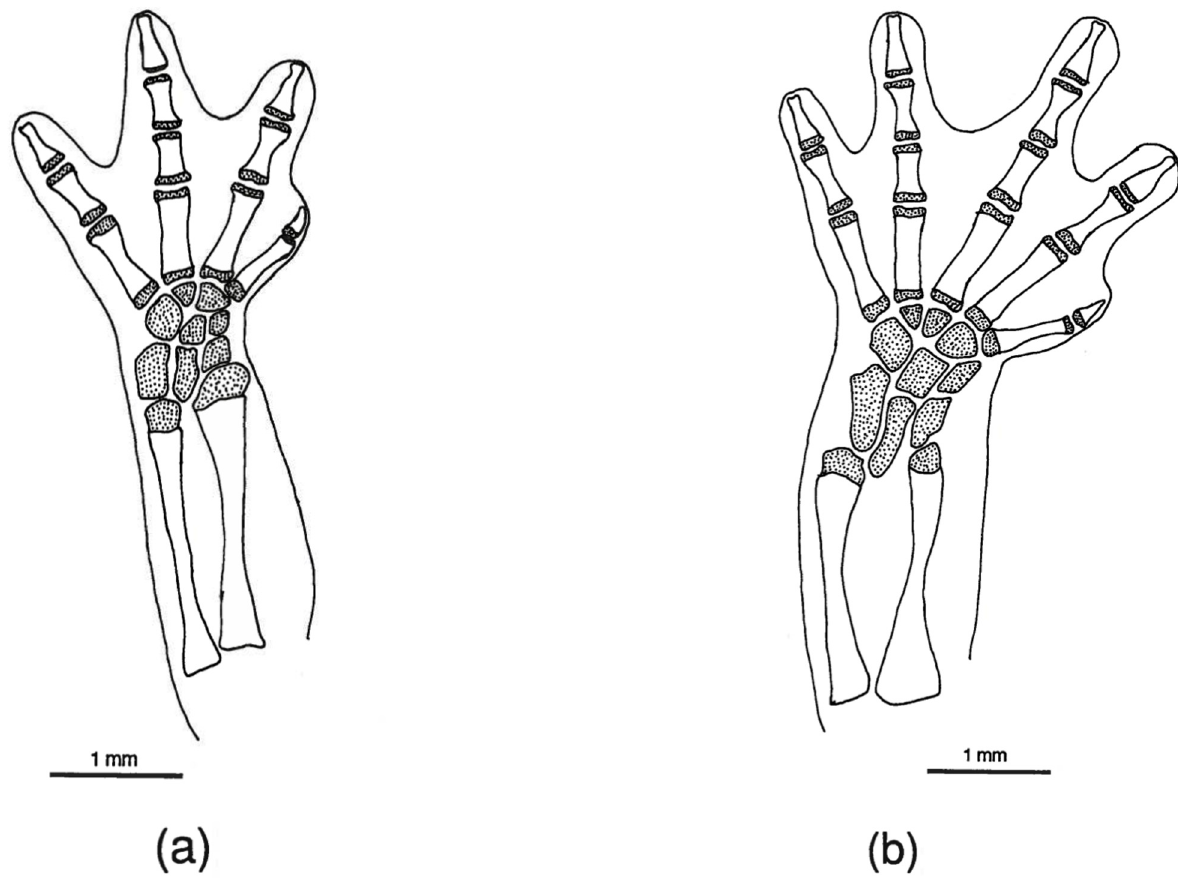
Fig 8. Chiropterotriton lavae feet. Drawings of front, left (a) and rear, left (b) feet of Chiropterotriton lavae (MVZ 171898), showing skeletal elements and the extent of interdigital webbing. Dorsal view; stippled areas represent cartilage. Elements as labeled in Fig